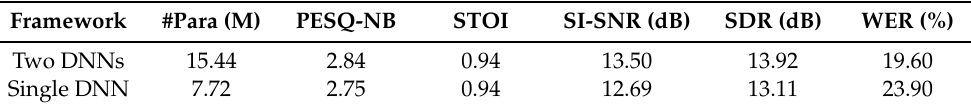
Table 4. Performance of systems using different frameworks.